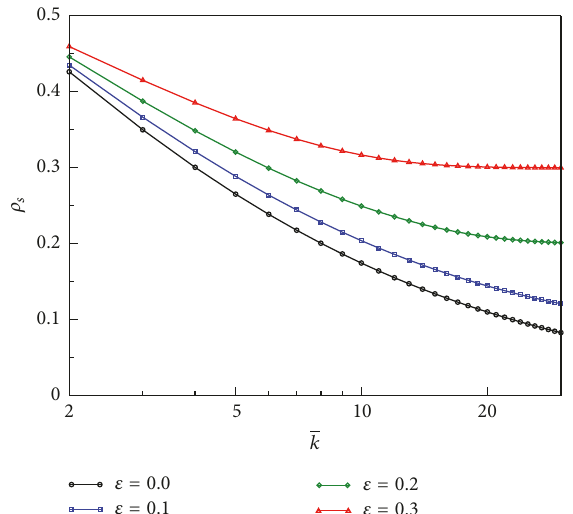
Figure 1: Best-shot game under BR dynamics in the mean field framework. Shown are the asymptotic cooperation values 𝜌 𝑠 versus the average degree 𝑘 for different values of the probability of making a mistake 𝜖 . Values are obtained by numerically solving